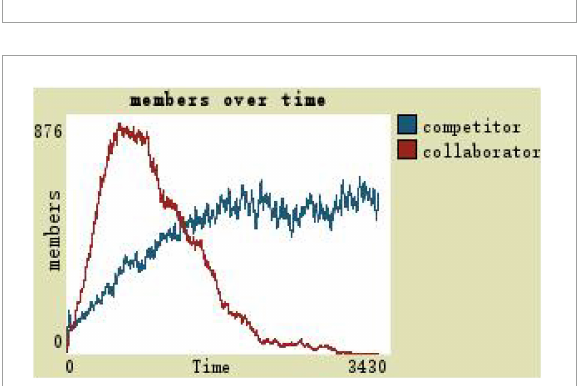
FIGURE12 Changes in team members at high incentive level.